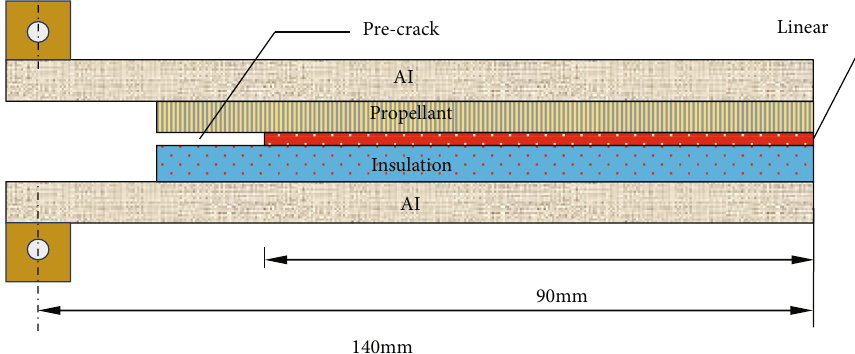
Pre-crack Linear